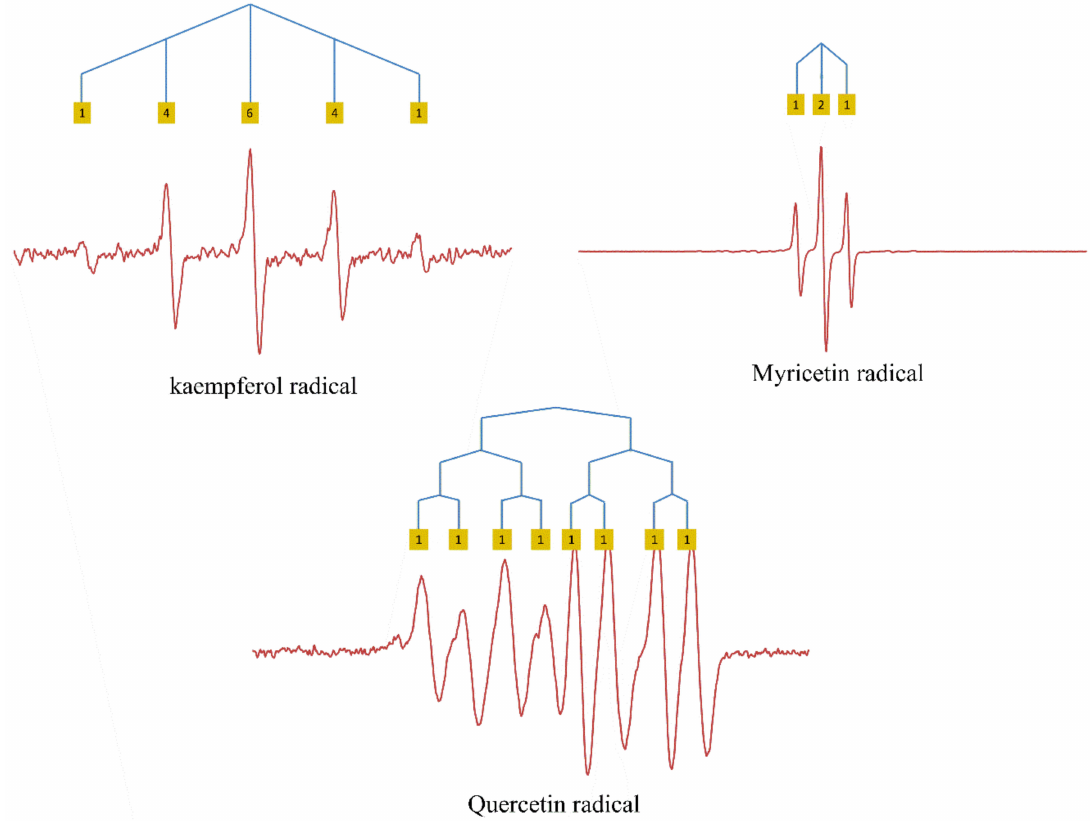
Figure 2. ESR spectra of flavonol radicals with the protons causing hyperfine couplings indicated. The relative intensities of peaks are given in yellow